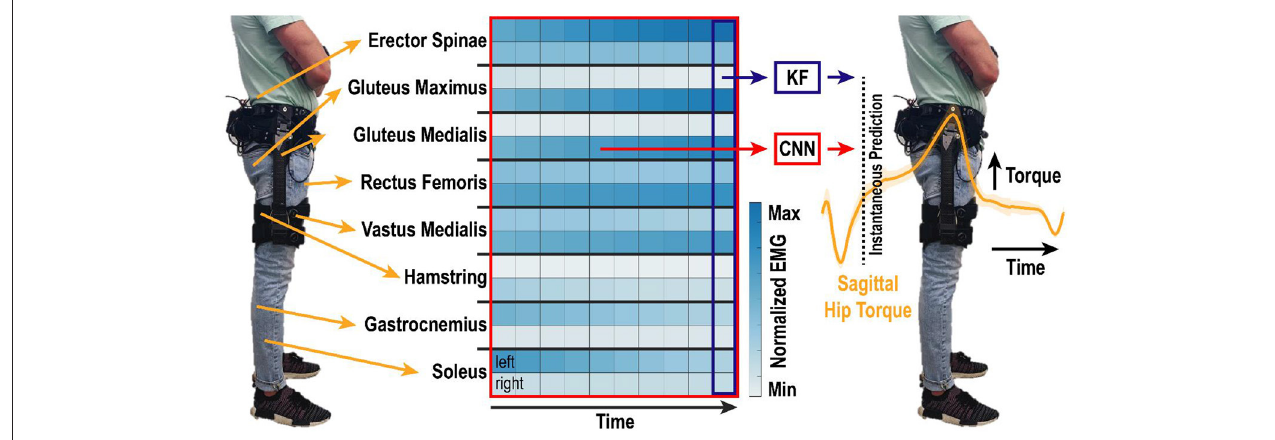
FIGURE 1 | Algorithm overview. EMG was recorded bilaterally from eight lower-limb muscle groups and motion capture was used to determine lower-limb kinematics and kinetics. EMG activity from the one most recent or ten most recent samples in time were used by the KF and CNN, respectively, to predict instantaneous torque of the right and left hips in the sagittal direction. Samples were analyzed at 200Hz, such that the total time window shown is 50ms. Heatmap shows example spatiotemporal EMG activity during walking. Differences across muscle groups (rows of two), between left and right legs (top and bottom rows, respectively), and over time (columns) create a rich set of features that are non-linearly correlated to hip